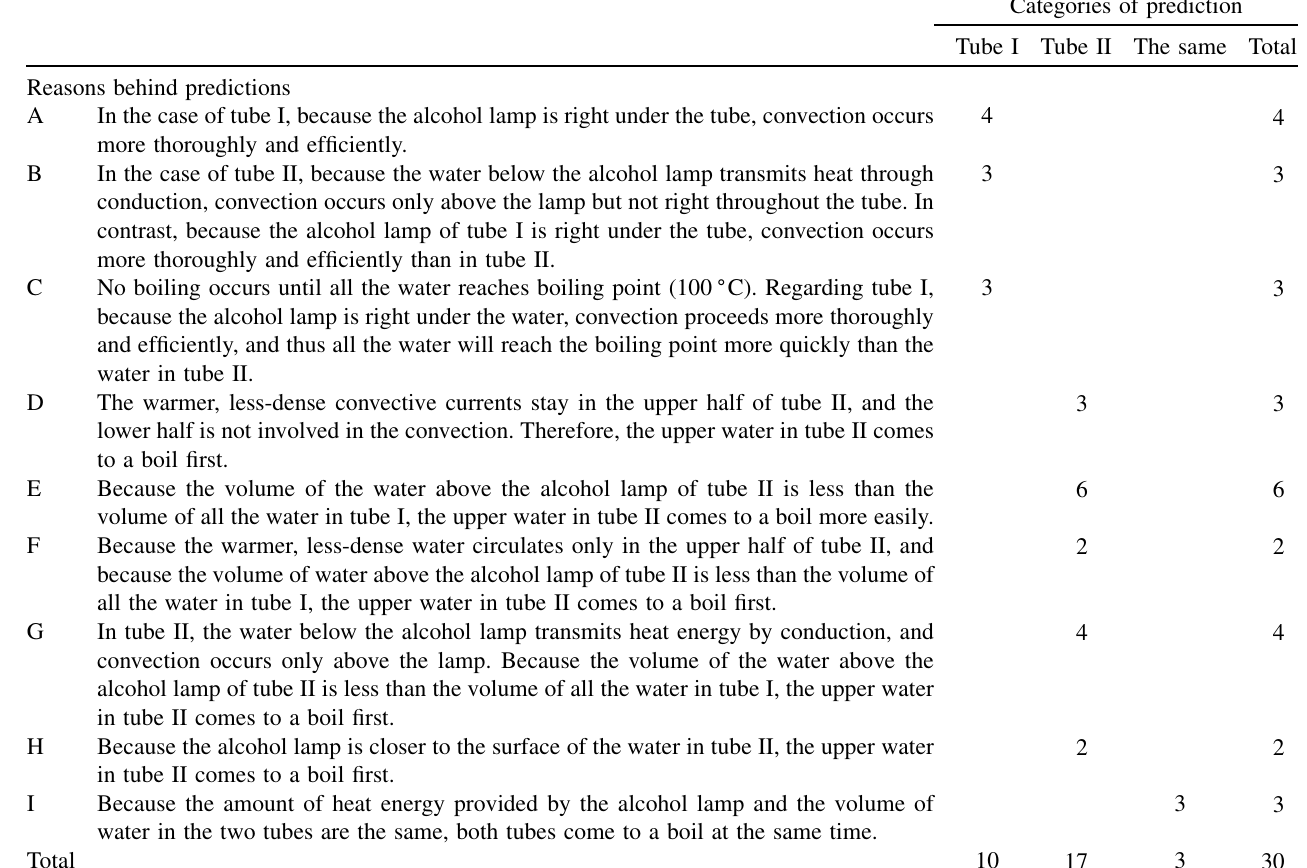
TABLE III. The participants’ explanations of their